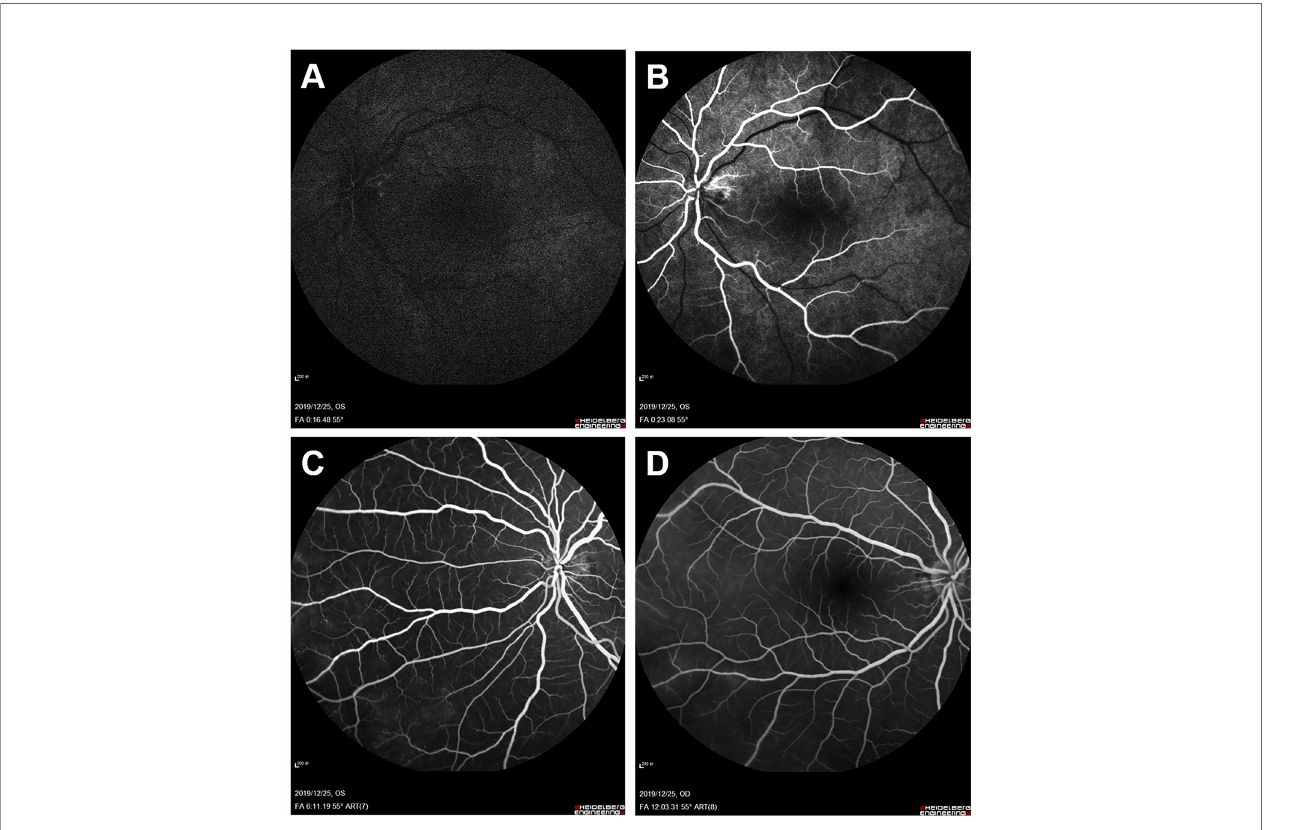
FIGURE 5 | Fundus fl uorescein angiography (FFA) 6 months after balloon angioplasty. Left eye angiogram reveals (A, B) restoration of retinal blood fl ow (decreased arm-to-retina circulation time to 16 s) and (C) decrease of microaneurysms with less evident leakage in the late phase. (D) Right eye angiogram in the late phase shows similar